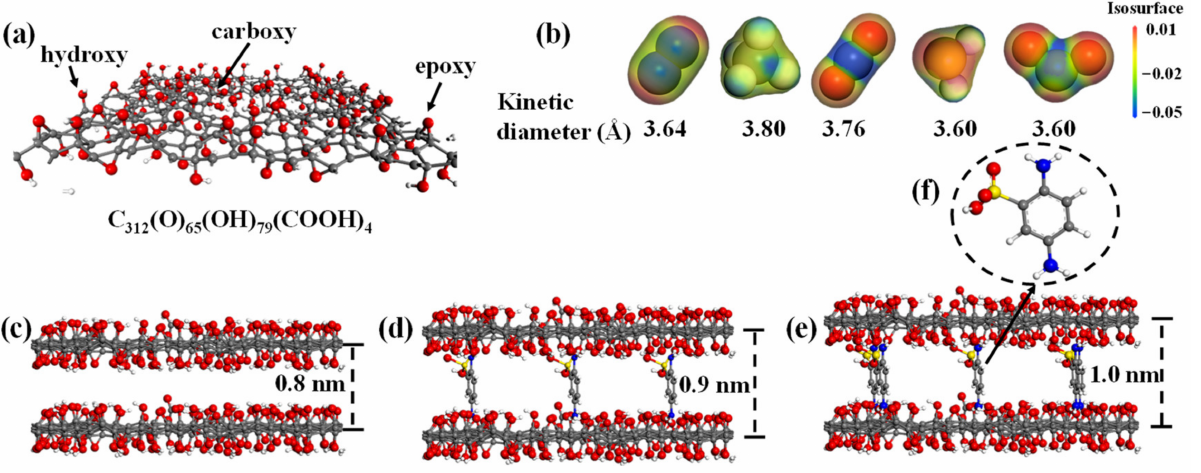
Figure 1. Simulation models. ( a ) GO nanosheet with the format of C 312 (O) 65 (OH) 79 (COOH) 4 . ( b ) Electrostatic potentials and kinetic diameters of gases. Configurations of GO membranes with variable PDASA-doping amounts: ( c ) 0.0%; ( d ) 4.5 wt%; ( e ) 7.5 wt%. ( f ) Molecular model of